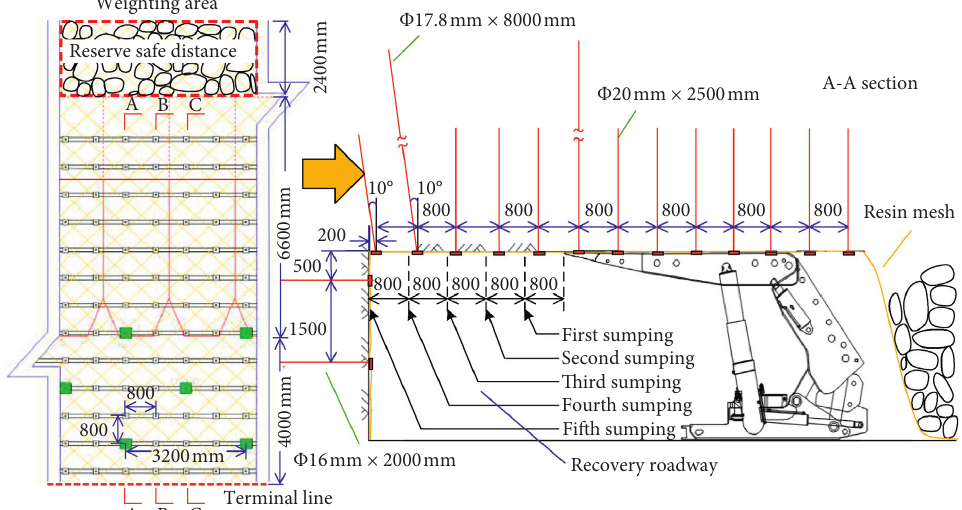
Figure 17: Initial support design of the recovery roadway in the Fengjiata coal mine.